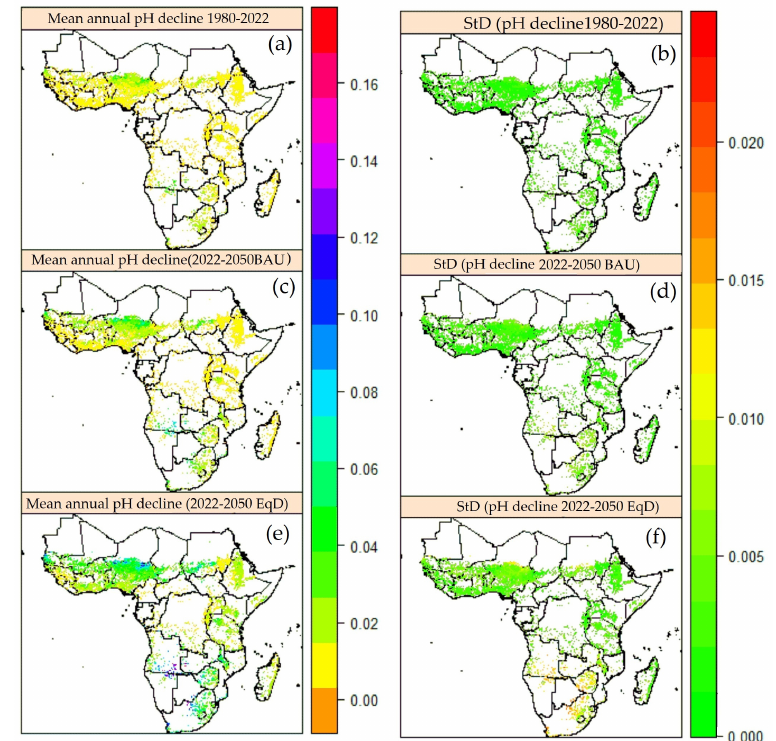
Figure 5. Spatial and temporal variations in soil pH decline in the last 42 years and prediction of soil pH decline in SSA croplands. ( a ) Mean annual pH decline map for 1980–2022, and ( b ) its standard deviation map. ( c ) Predicted soil pH decline map in the BAU scenario, and ( d ) its standard deviation map. ( e ) Predicted soil pH decline map in the EqD scenario, and ( f ) its standard deviation map. See Figure S4 for all scenario maps for soil pH decline. soil pH was observed in the central part of SSA (Figure 6a).